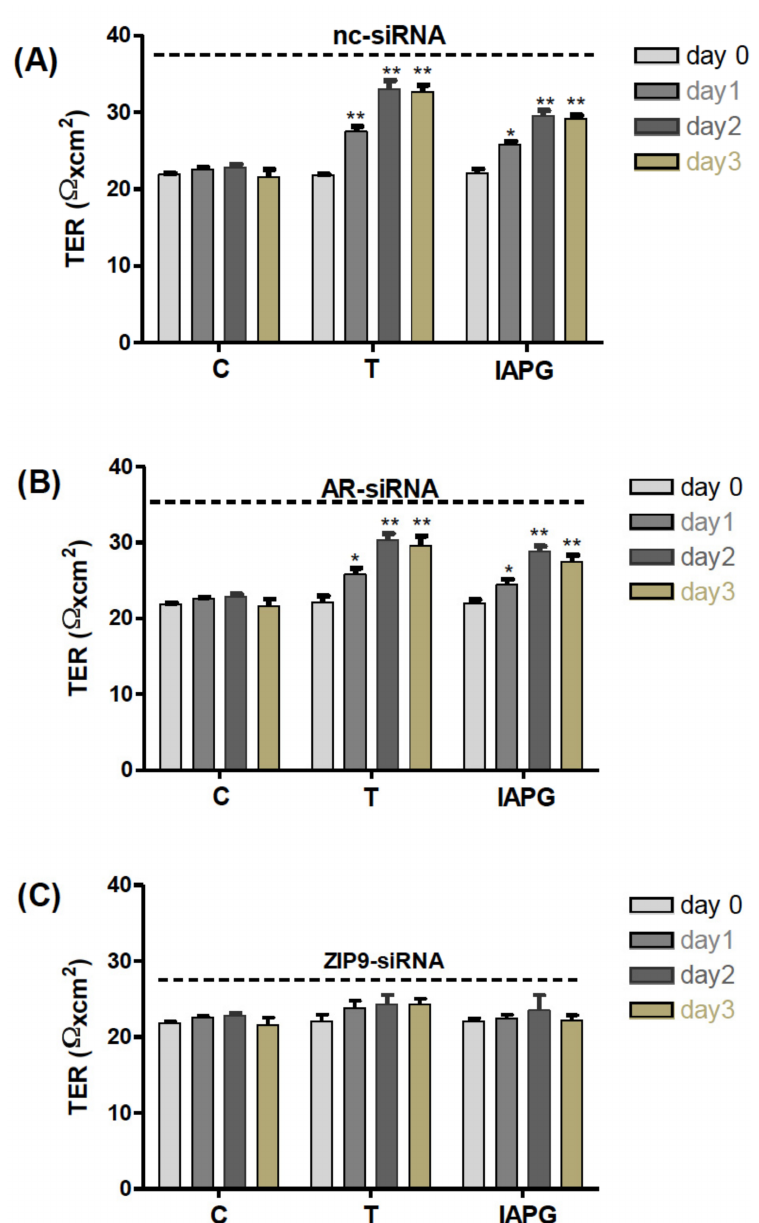
Figure 11. Transepithelial electrical resistance (TER) across adult Sertoli cell layers. The PASC1 cells were treated with either nc-siRNA ( A ), AR-siRNA ( B ), or ZIP9-siRNA ( C ) before being exposed to vehicle (C), 10 nM testosterone (T), or 10 µ M or IAPG (P). Measurements of TER were taken after 0, 24, 48, and 72 h. For each data point: n = 6; means ± SEM; * p ≤ 0.05; ** p ≤